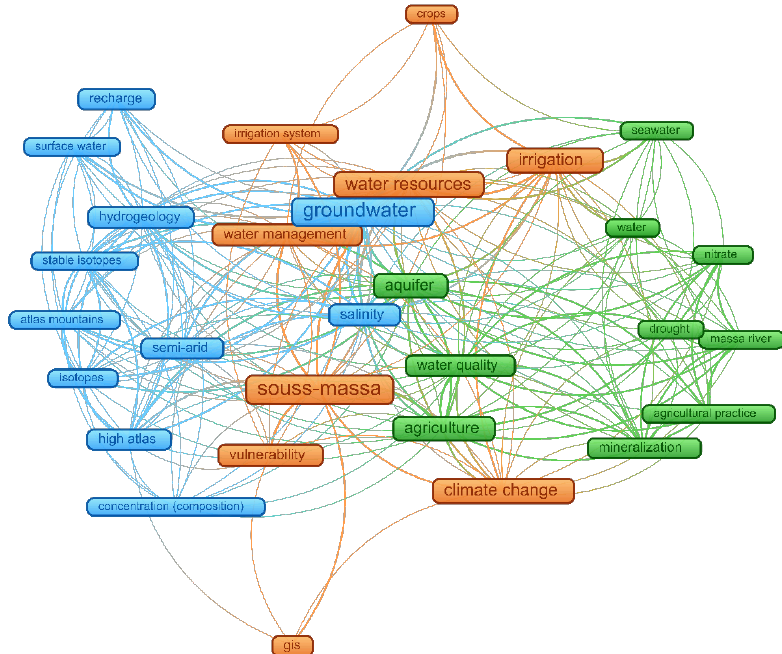
Figure 5. Network view map generated in VOSviewer from material from Scopus and WOS using co-occurrence of keywords.